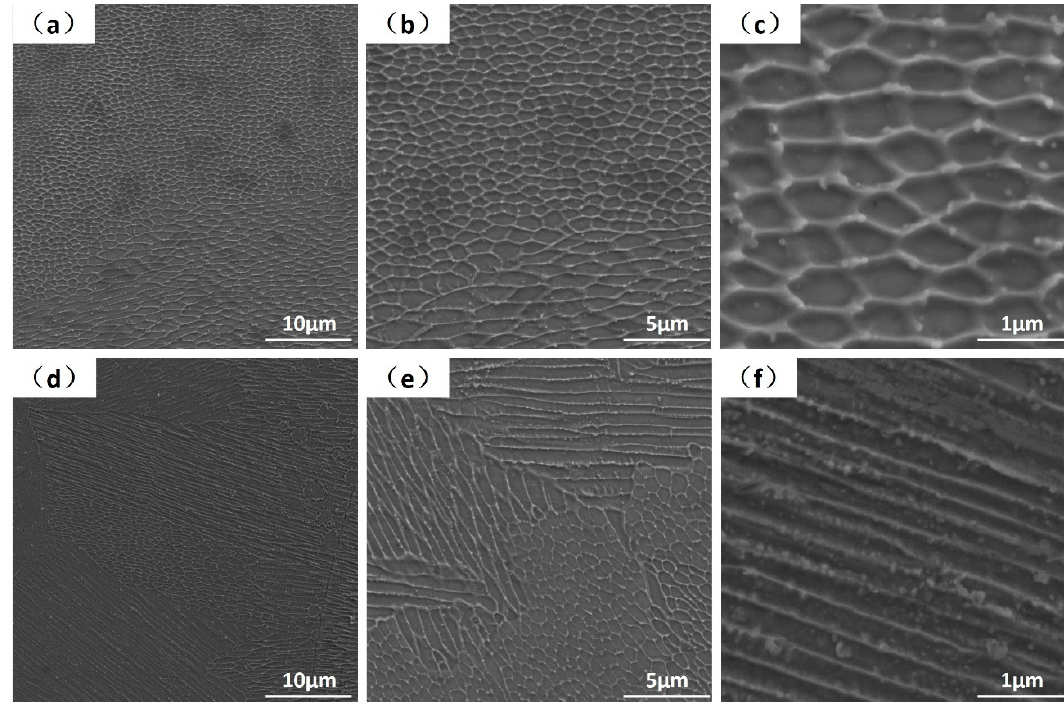
Figure 5. The SEM images of a variety of sub-grain microstructures; with mixed cellular and band morphologies ( a – f ). All the images were exposed upon a transverse cross-section normal to the building direction.